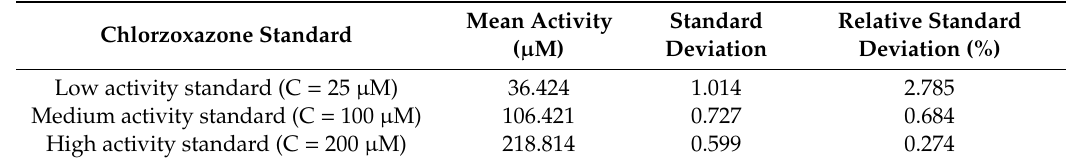
Table 3. Intra-assay variation for chlorzoxazone ( n = 3).